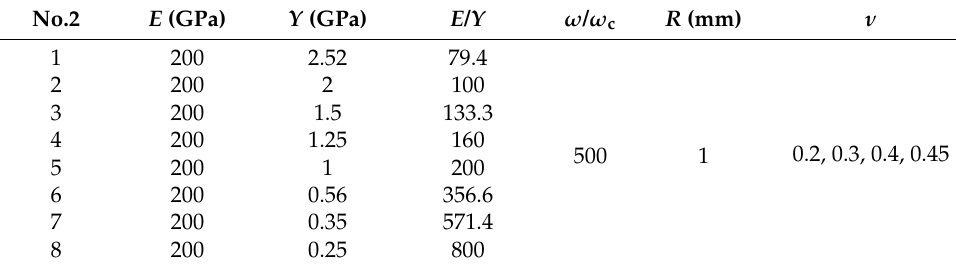
Table 3. Material properties in the second group.